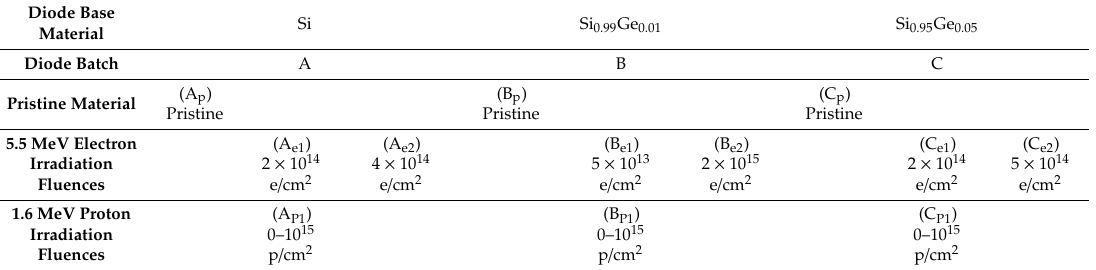
Table 1. The diodes under test, made on p-type Si and SiGe material substrates of the same doping. Diode Base